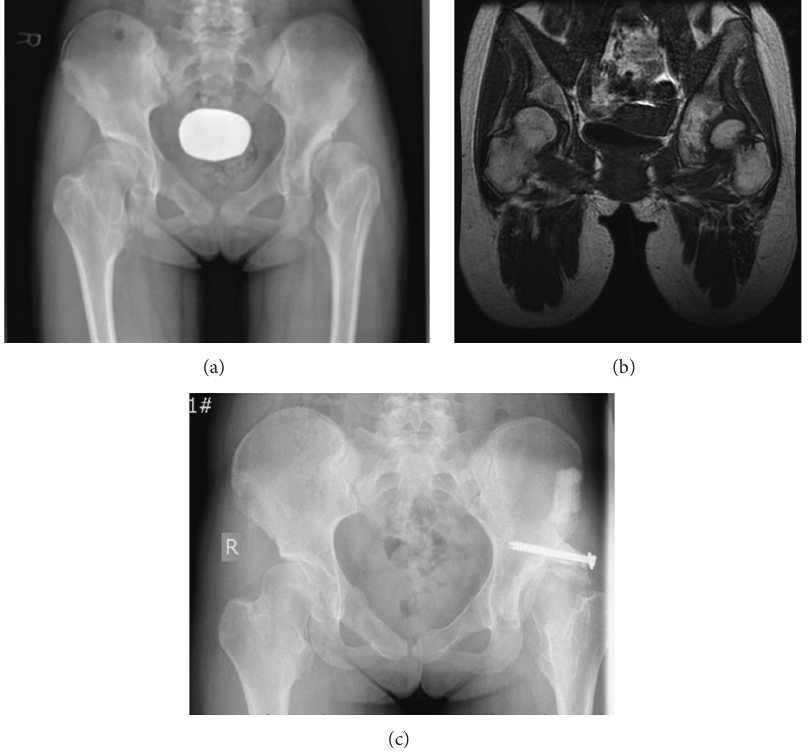
Figure 3: (a) Anteroposterior pelvic radiograph at initial presentation. (b) Magnetic resonance imaging showing a large sessile osteochondroma within the left acetabular fossa. (c) Anteroposterior radiograph of the pelvis 3 years after the left acetabular Shelf procedure and femoral neck